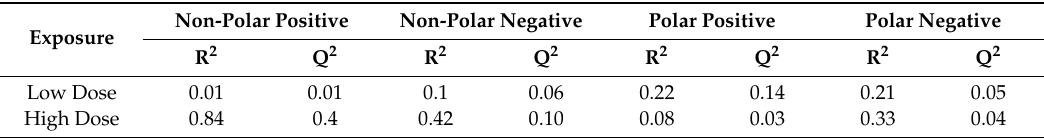
Table 2. R 2 and Q 2 values for the PLS-DA discrimination between the exposure groups and the negative control